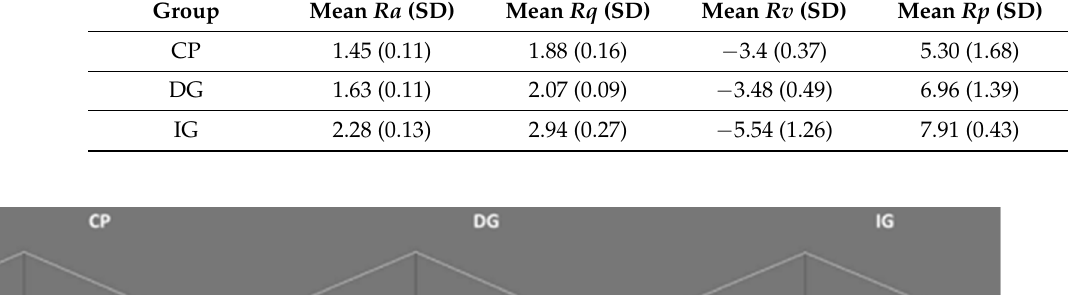
Figure 6. ( a – f ) SEM images show an example of a fracture pattern at different magnifications. The red arrow shows a point of fracture initiation and direction of crack propagation through the glaze layer.